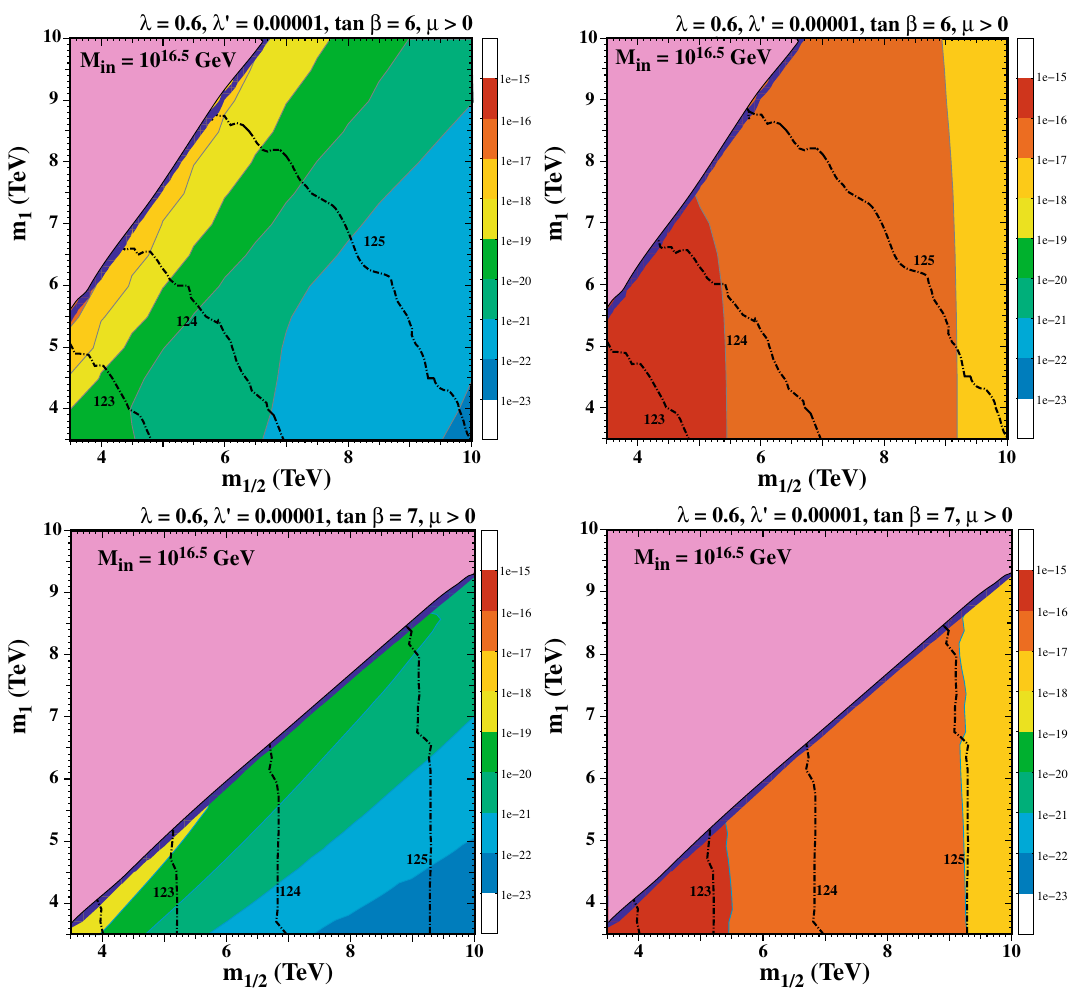
tan β = 7 and the indicated values of λ and λ (cid:8) (lower panels).